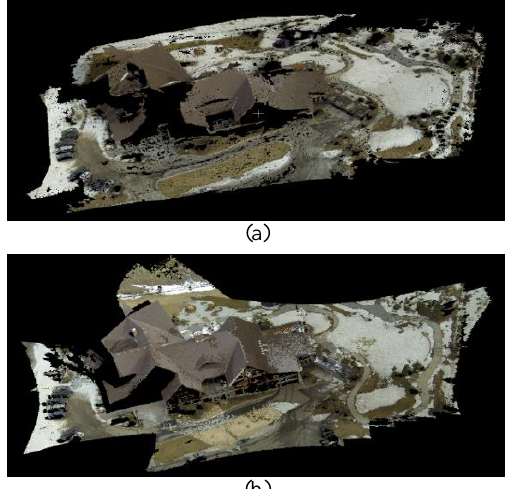
Figure 3. The impact of poor system calibration on the quality of the generated 3D point clouds using: (a) inaccurate and (b) accurate camera calibration parameters